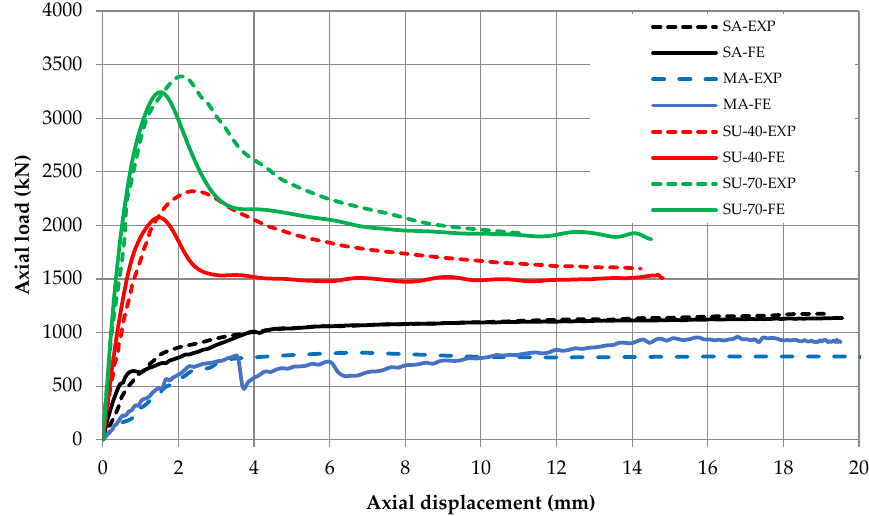
Figure 11. Load-deflection curves of the simulated models.